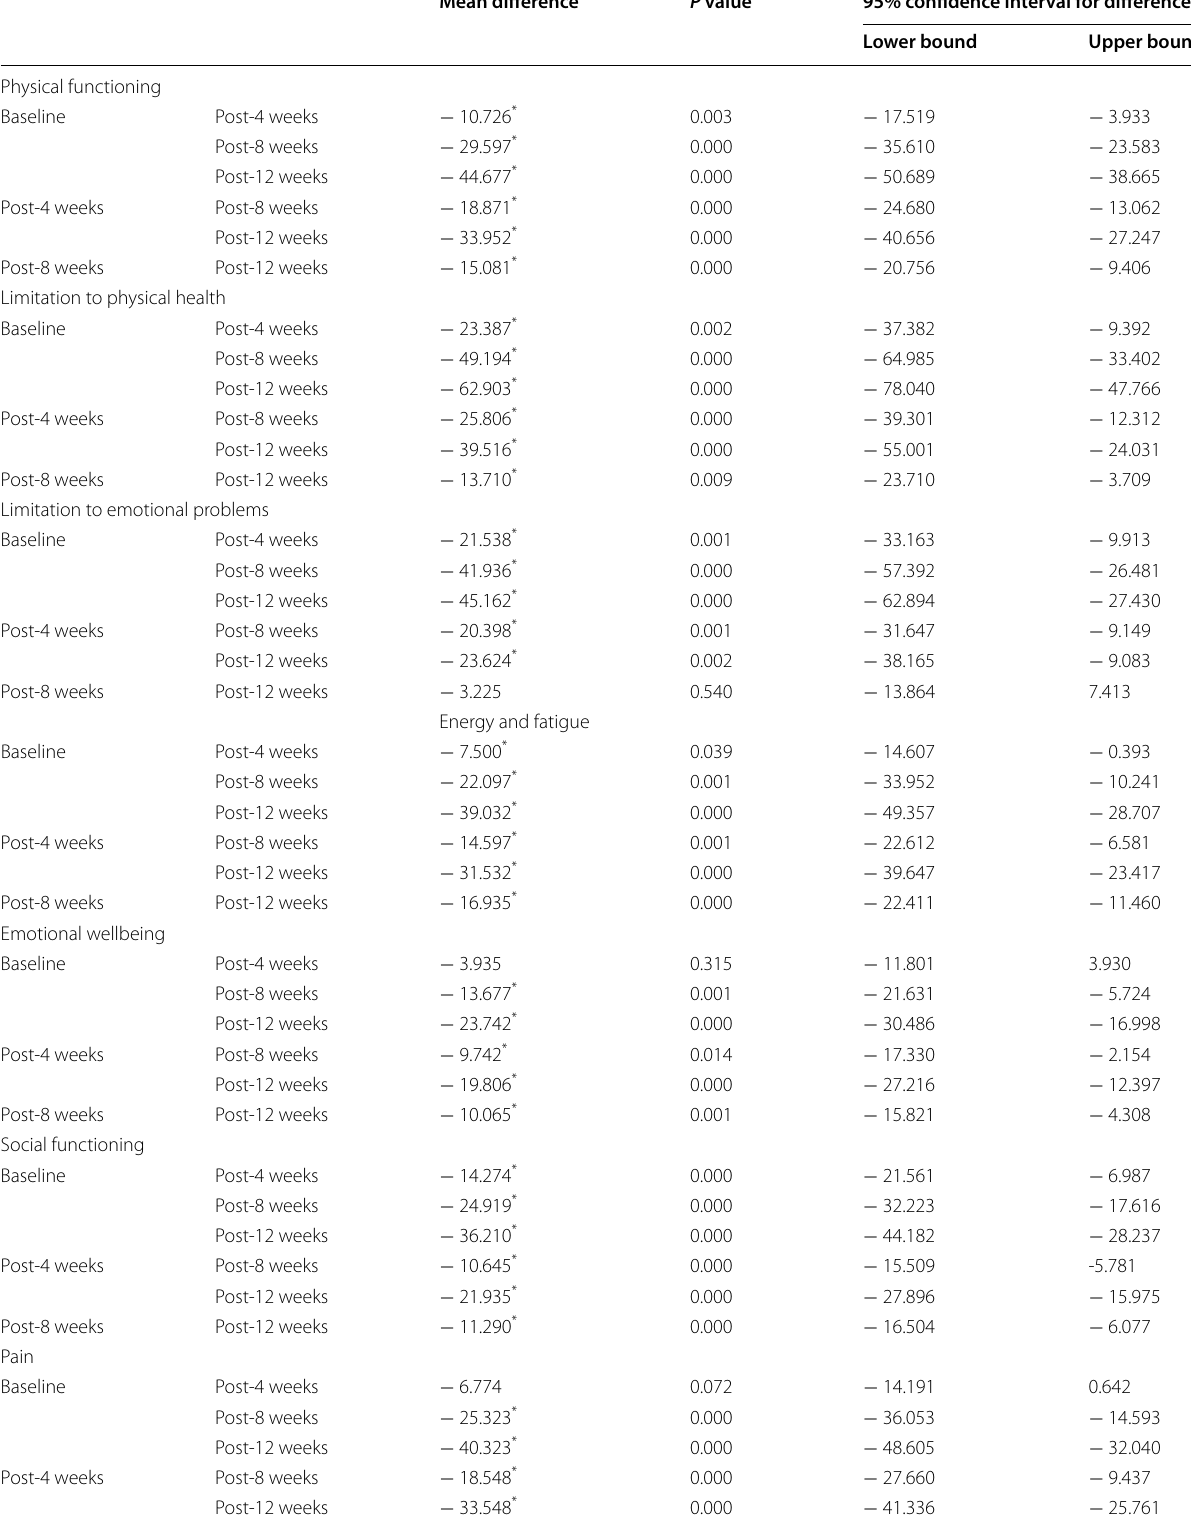
Table 5 Pairwise multiple comparison of domains of quality of life for baseline to post-4 weeks, post-8 weeks, and post-12